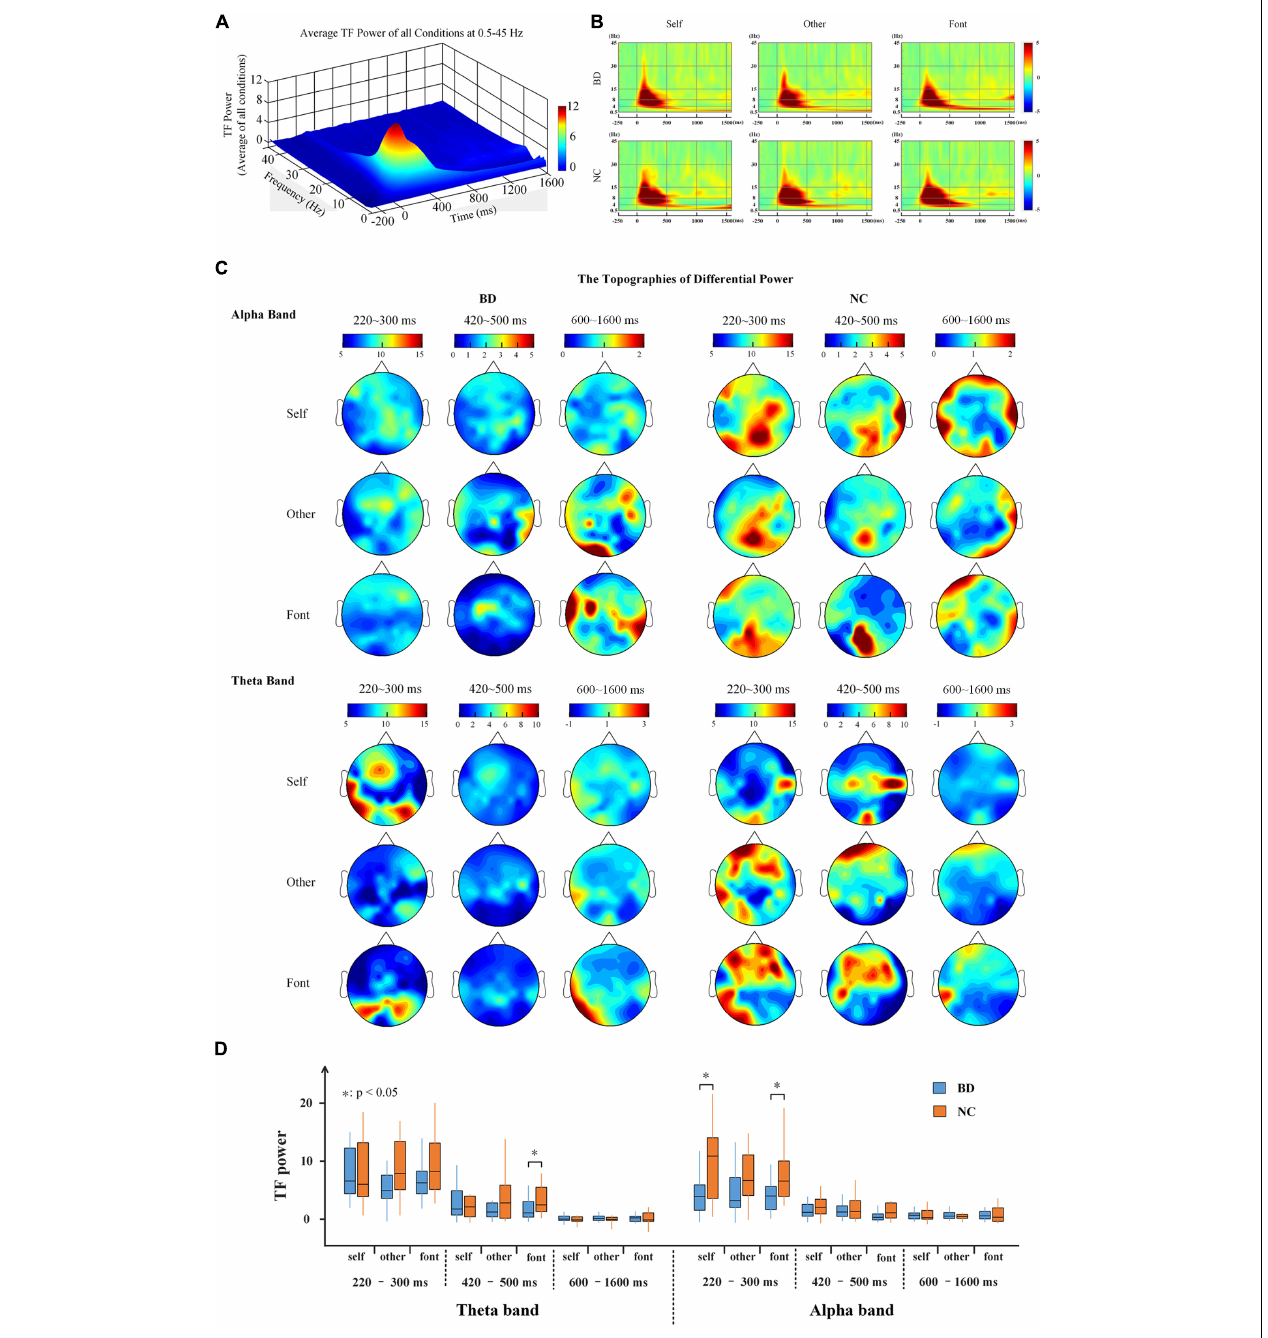
FIGURE 3 | (A) The average TF power of all electrodes at 0.5–45 Hz from –250 to 1,600 ms after the onset is illustrated. (B) The TF power shows the phase-locked spectral power at 0.5–45 Hz from –250 to 1,600 ms in response to the three conditions at all electrodes. (C) The topographies illustrate the power distribution of the three time periods in the theta and alpha bands. (D) A box plot of the TF power for BD and NC under the three conditions in terms of the alpha and theta band activity levels. BD, bipolar disorder; NC, normal control; TF, time frequency.